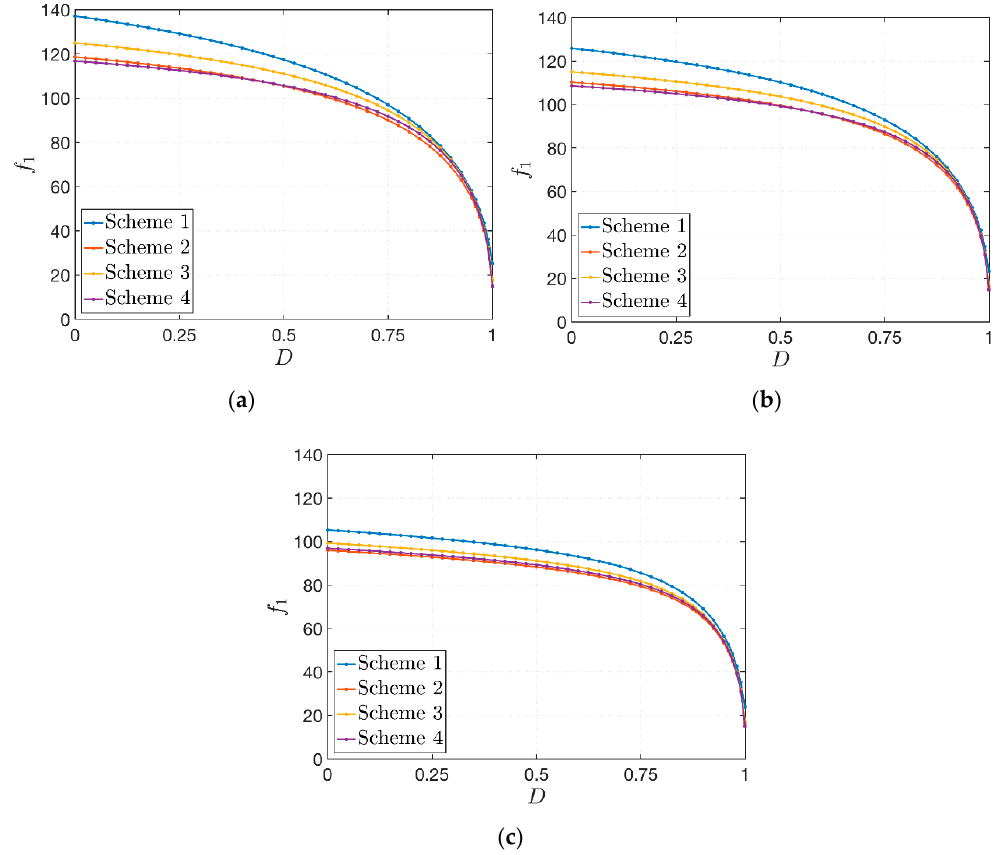
Figure 6. Variation of the first natural frequency f 1 [Hz] for sandwich plates with a damaged soft-core due to an increasing damage D , for three different lamination schemes: ( a ) (0°/core/0°); ( b ) (30°/core/45°); ( c ) ( − 45° /core/45°).